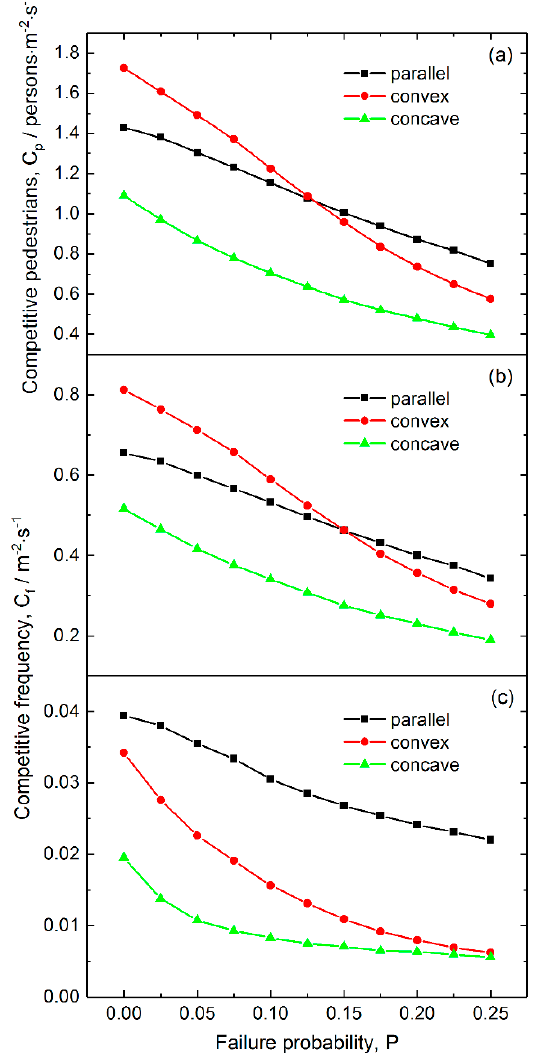
Figure 8. Competitive intensity as a function of checking failure probability for the three layouts of inspection points: ( a ) Competitive pedestrian-time, ( b ) two-person competitive frequency and ( c ) three-person competitive frequency. The pedestrian density and average delay are 3.5 persons/m 2 and 3 s, respectively.